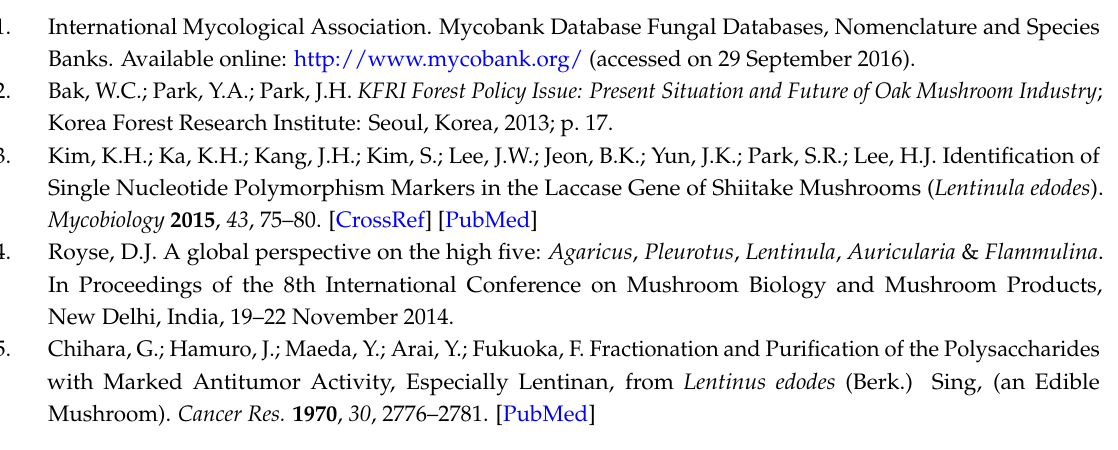
Figure S1: The development process of SSR marker developed using genome sequencing for Lentinula edodes , Figure S2: Distinguished Lentinula edodes strains using the 44 novel SSR markers developed in this study. Acknowledgments: This study was performed with the support of the “Golden Seed Project (Center for Horticultural Seed Development, No.